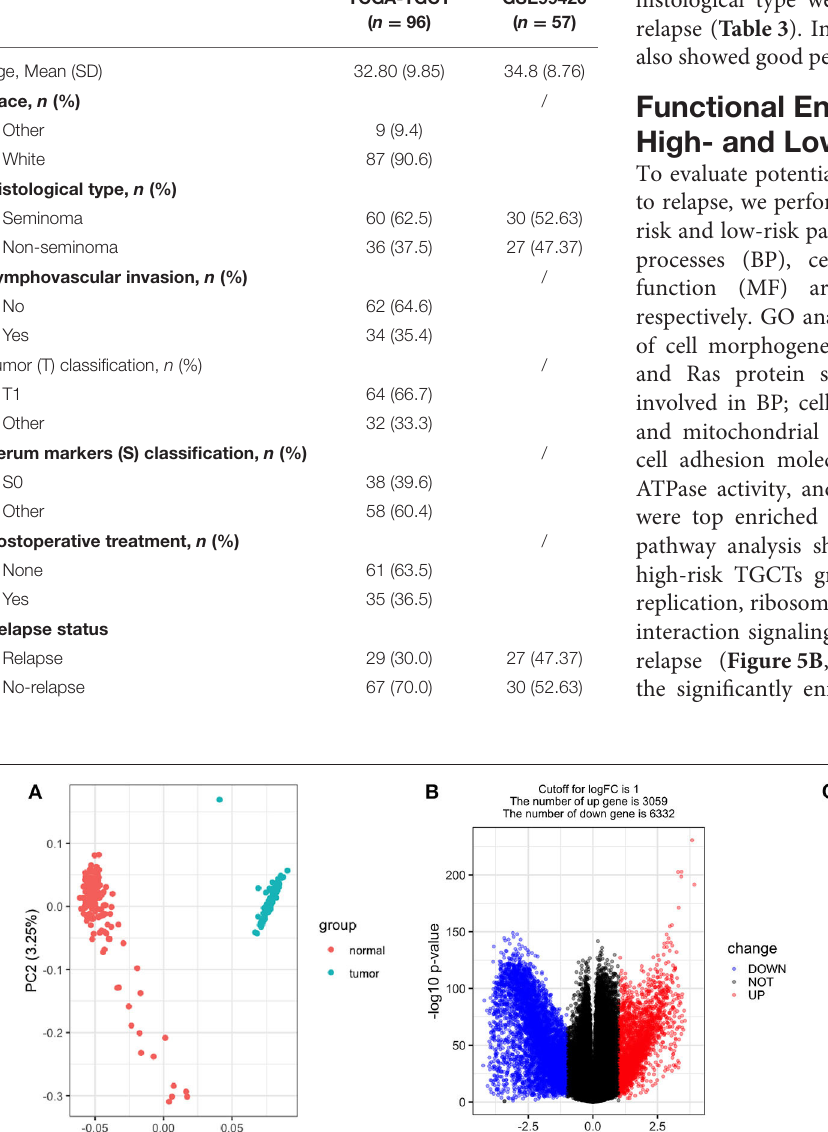
Frontiers in Oncology |